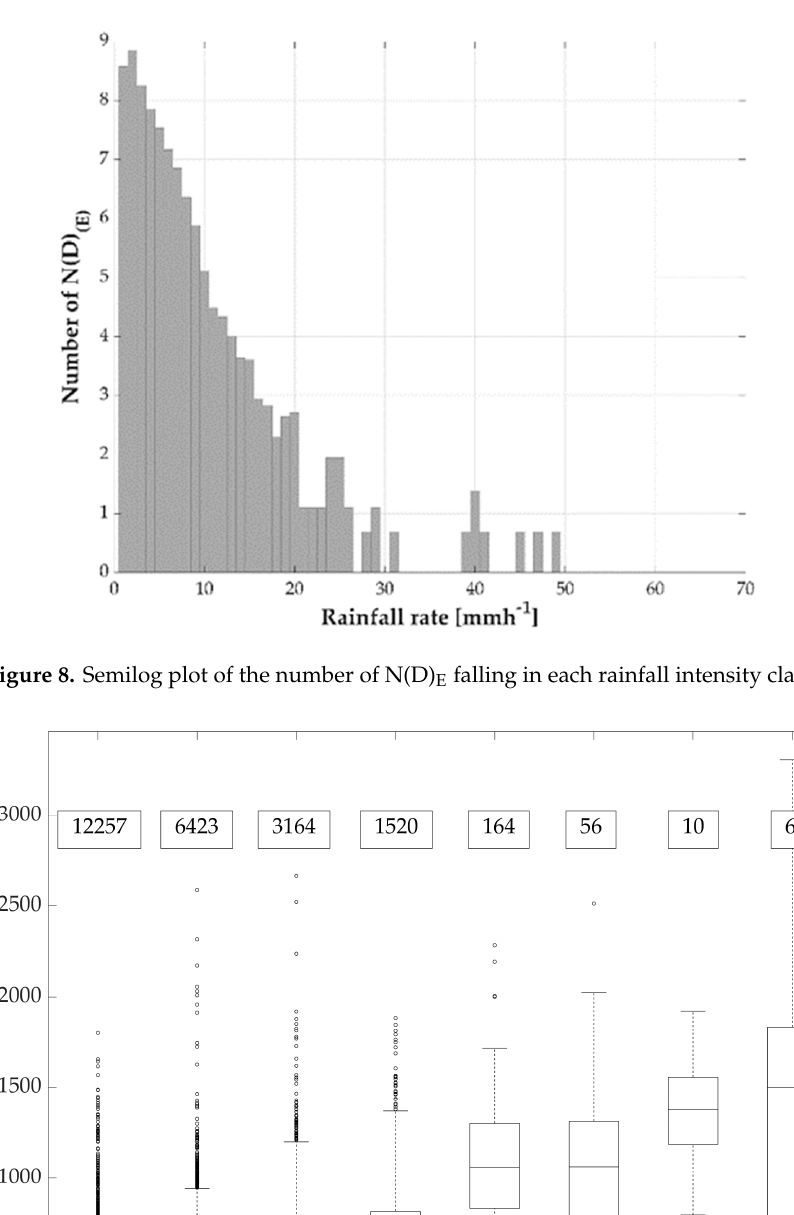
Figure 8. Semilog plot of the number of N(D) E falling in each rainfall intensity class.